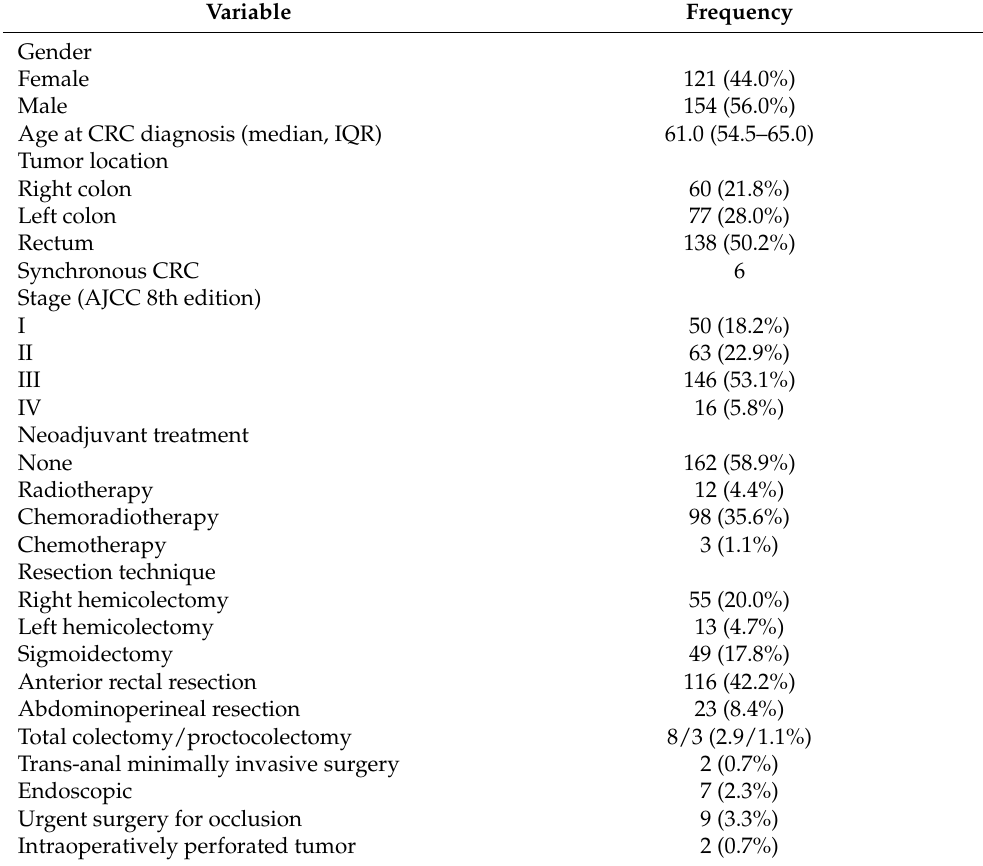
Table 2. Clinical